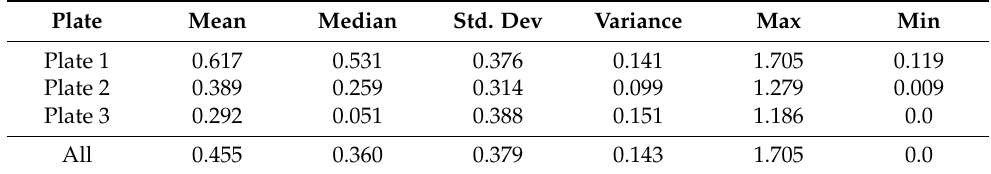
Table 9. Data extracted for the plates with SM.